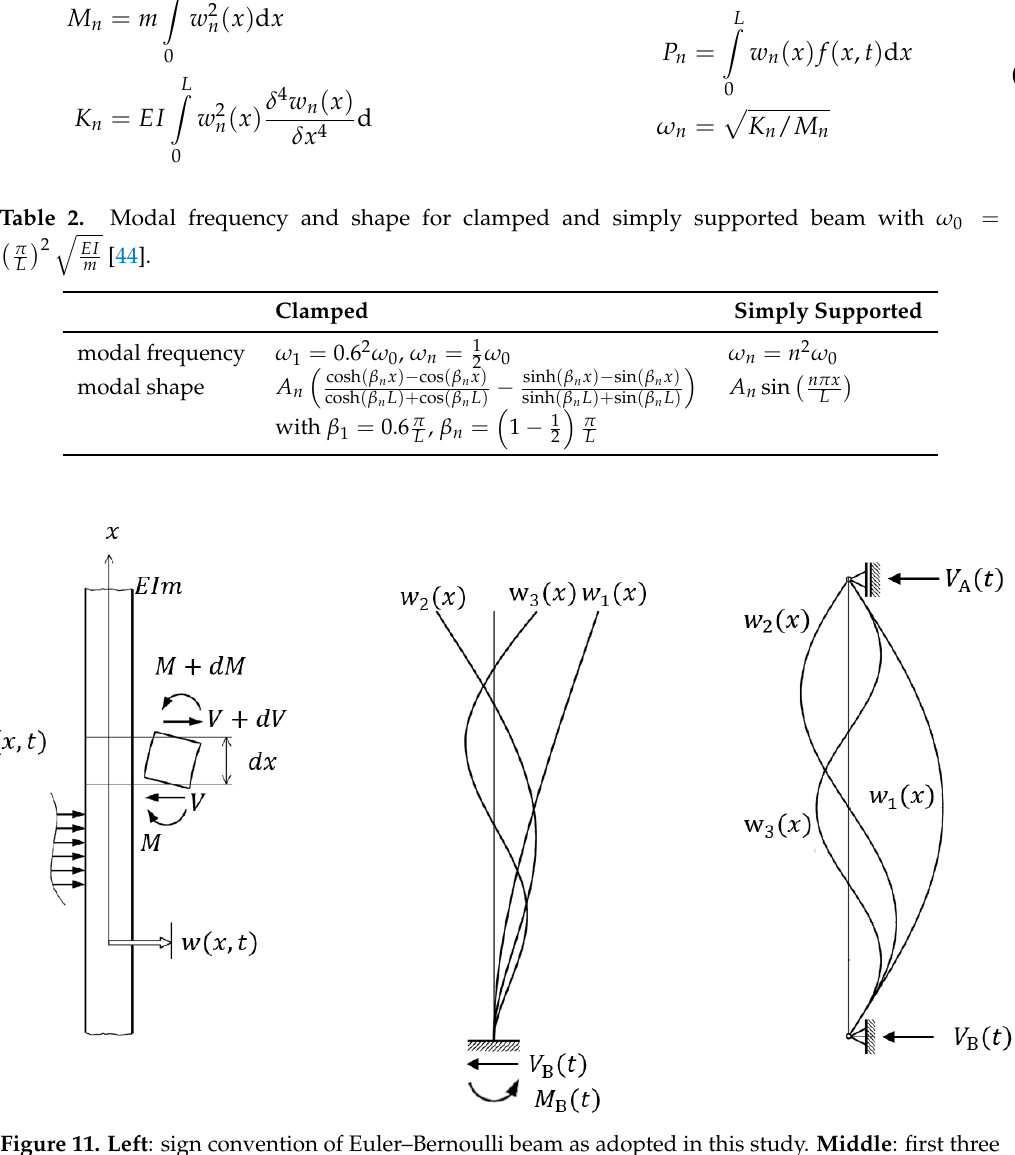
Figure 11. Left : sign convention of Euler–Bernoulli beam as adopted in this study. Middle : first three modal shapes of clamped Euler–Bernoulli beam. Right : first three modal shapes of simply supported Euler–Bernoulli